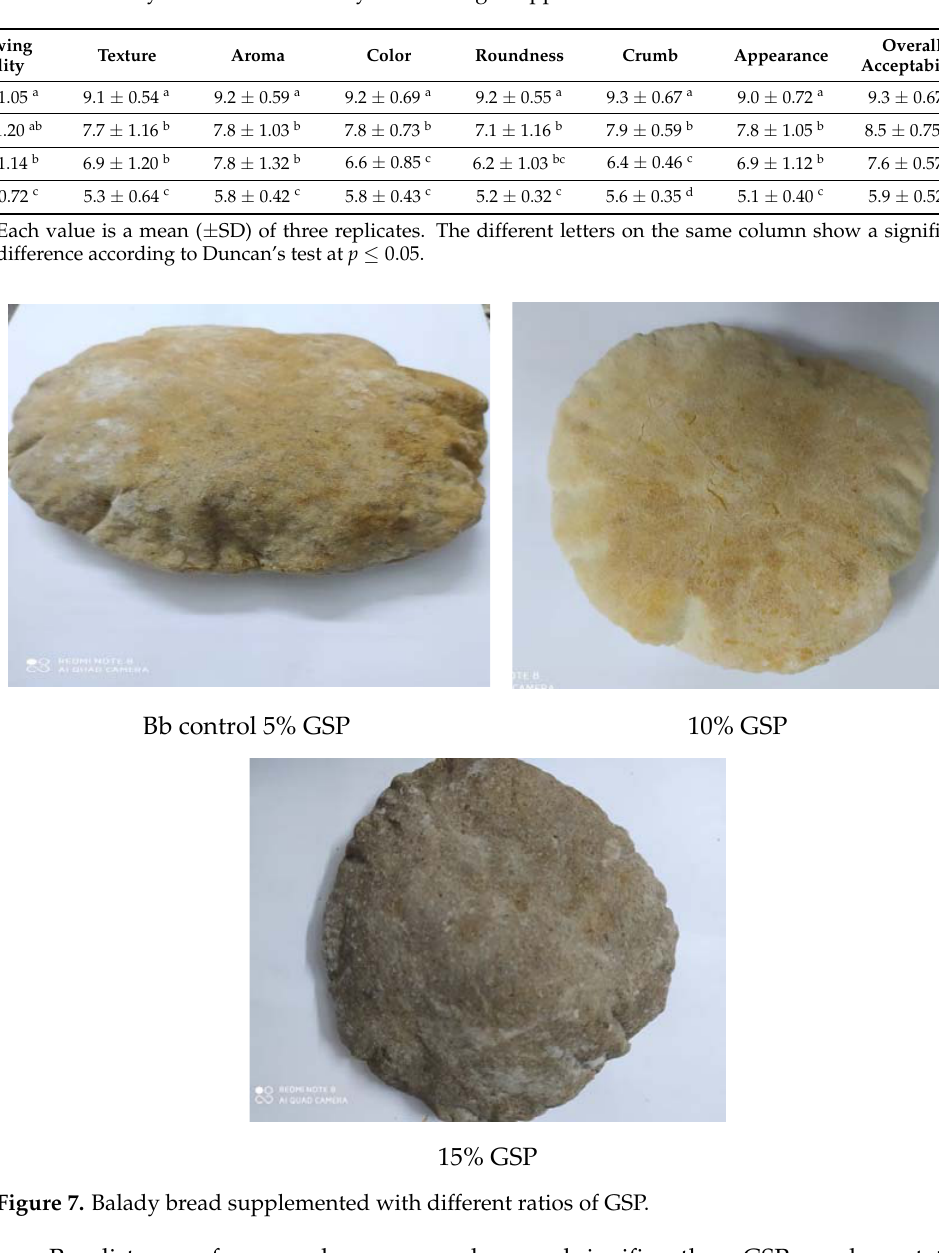
Table 5. Sensory evaluation of balady bread dough supplemented with different ratios of GSP.